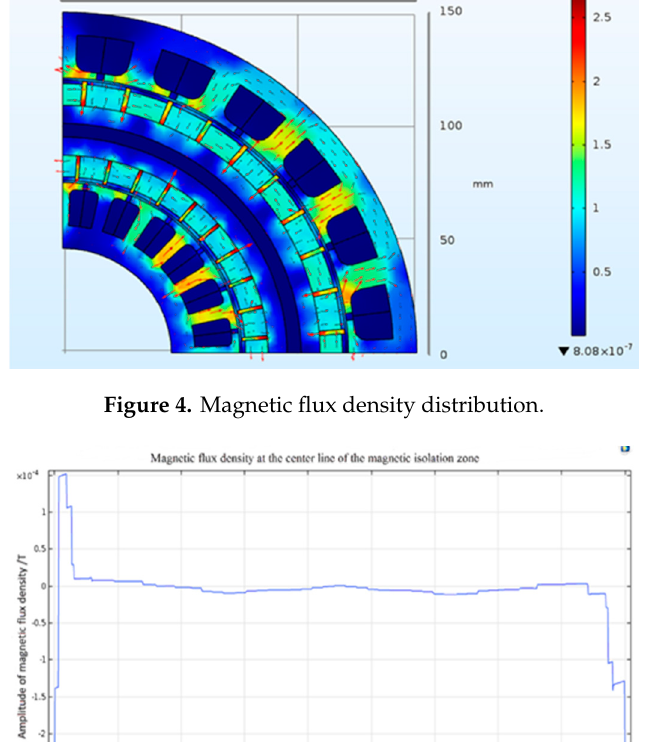
Figure 6. Relationship between K 1 and the performance of the external torque.